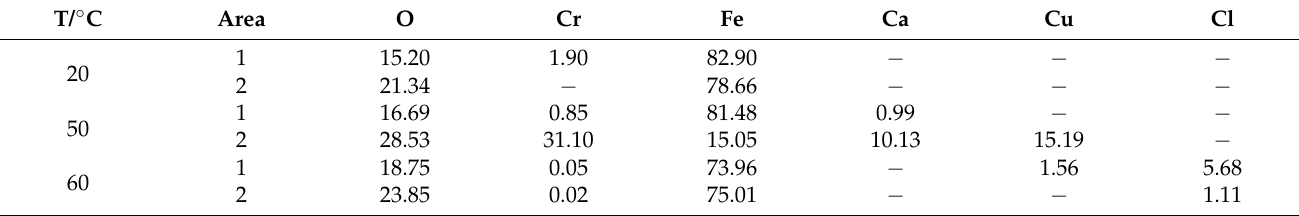
Table 4. EDS results of the corrosion scales after 168 h flow loop test.